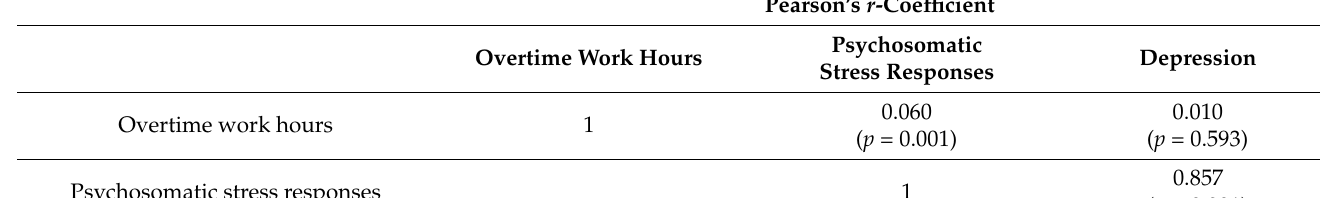
Table 2. Correlation between overtime work hours, psychosomatic stress responses, and depres- sion.